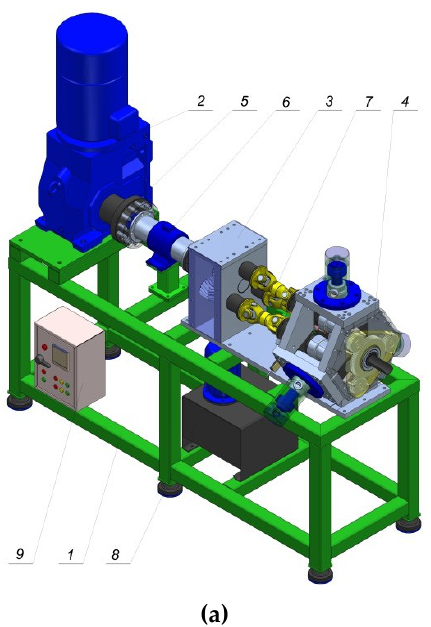
(b) Figure 6. Shape of the formed shafts with extreme neckings: ( a ) finite element method (FEM)-determined (along with the effective strain distribution); ( b ) obtained during laboratory testing ( δ = 1.5; v/n = 4 mm/rotation)